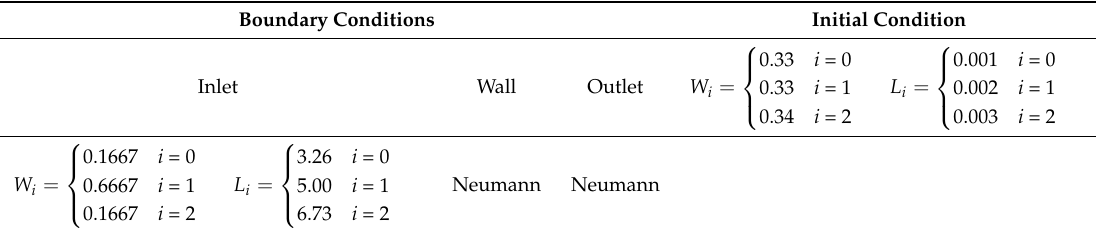
Table 12. Boundary and initial conditions for W i and L i equations used in the DQMOM method [33]. Boundary Conditions